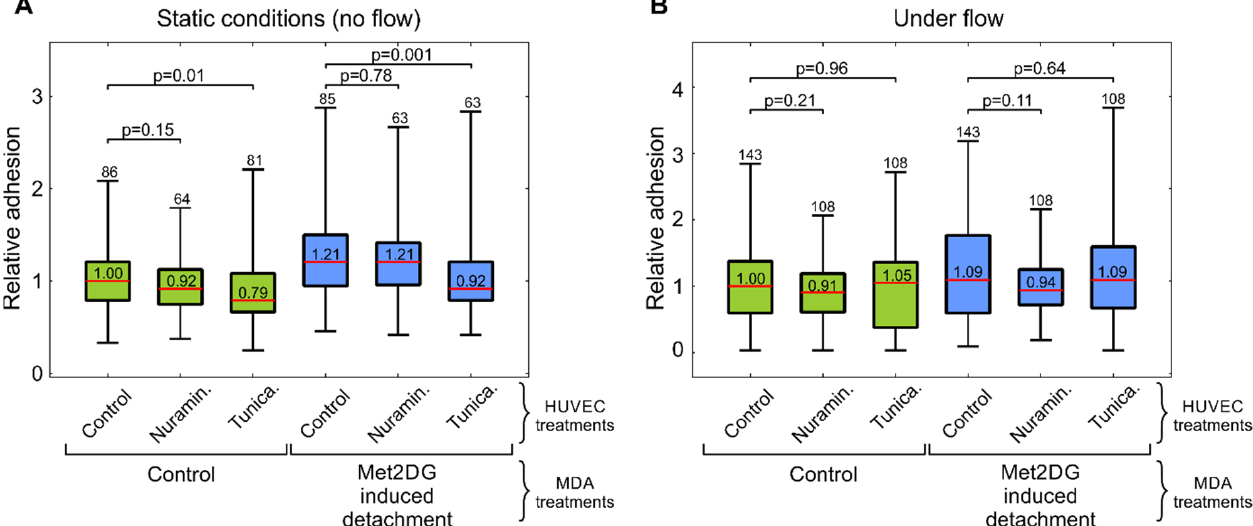
Figure 5. Adhesion of floating MDA-MB-231 cells onto confluent layer of treated HUVEC cells measured in flow-free conditions ( A ) and under microfluidic flow ( B ). Floating MDA-MB-231 cells were obtained by trypsinization (control) and by met2DG-treatment. HUVEC cells were either non-treated (control) or treated by neuraminidase and by tunicamycin. The adhesion was quantified as the number of adhered cells per field-of-view relative to the adhesion of non-treated MDA-MB-231 on non-treated HUVEC control. The red horizontal lines represent the medians, boxes span over 50% of the data points and the whiskers span over the total data range. The median value is indicated in the box, the number of measured FOVs indicated at the top and the p -values describe the difference relative to the control. Met2DG-treated MDA-MB-231 cells consistently show stronger adhesion than non-treated MDA-MB-231 cells. The results were obtained from four independent